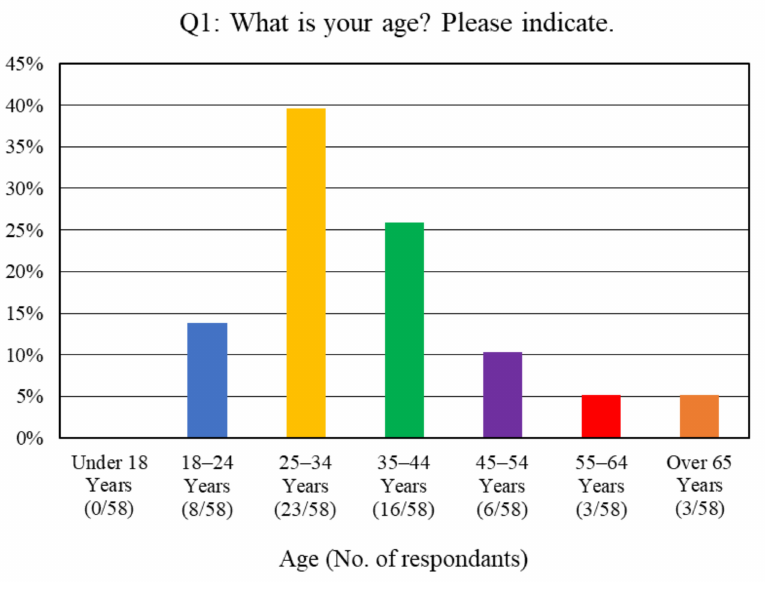
Figure 2. Participants’ age